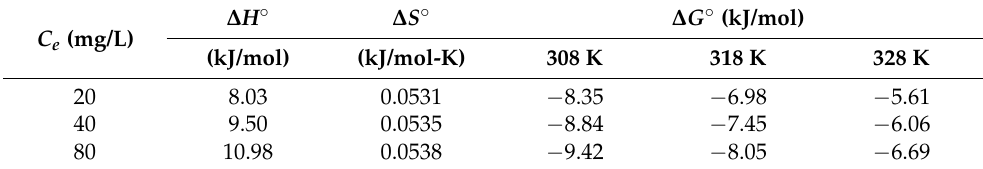
Figure 12. The plot of ln ( K d ) versus 1/ T for MB adsorption onto mesoporous-activated carbon (A6). Table 9. Thermodynamic parameters of the MB adsorption on longan seed-activated carbon.